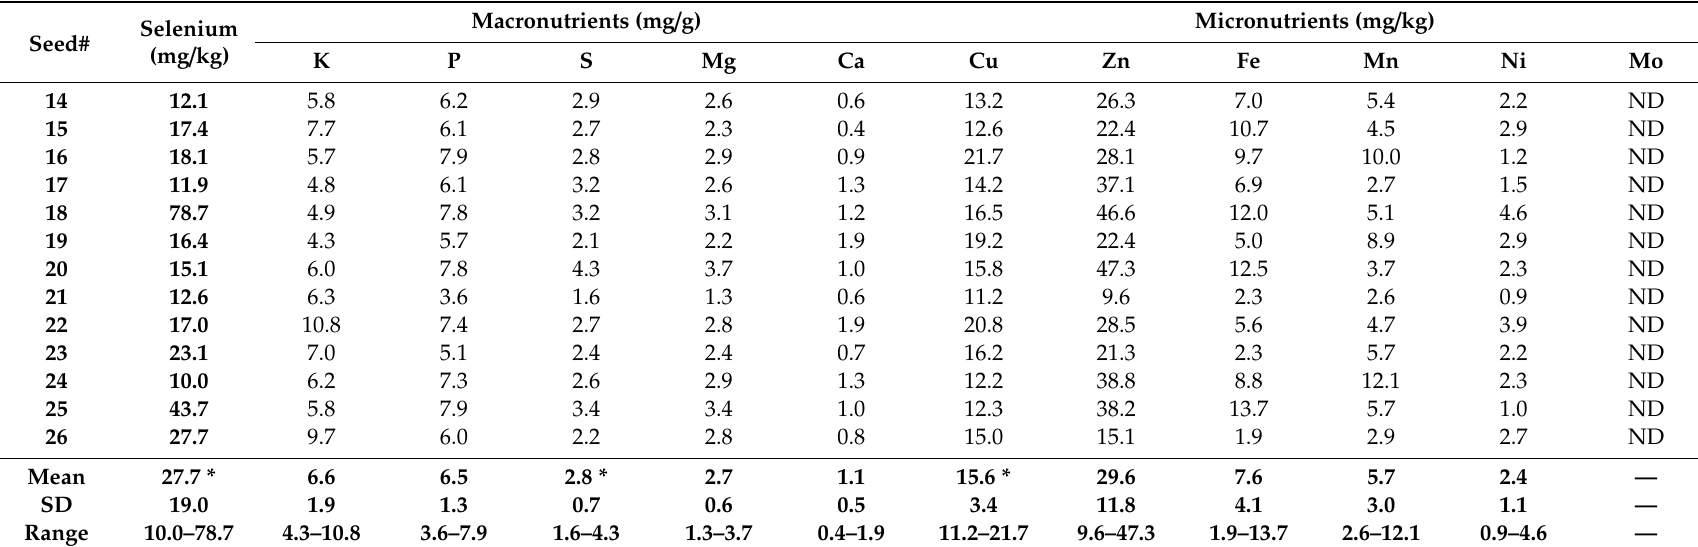
Table 2. Elemental composition of 13 commercially available Brazil nuts (Batch B), imported from